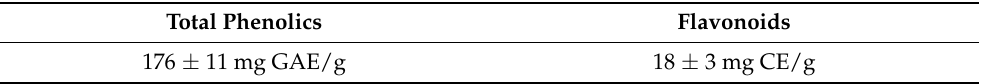
Table 1. Total phenolic compounds and flavonoids of pomegranate peels extract.